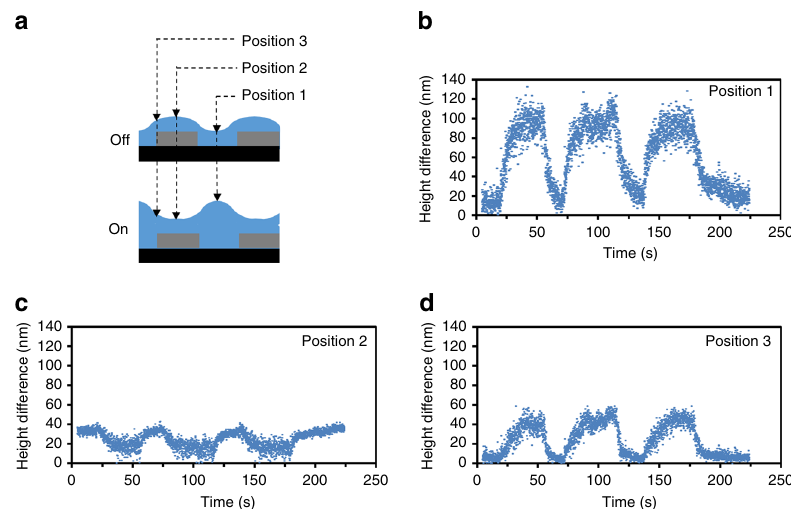
Fig. 4 Formation and relaxation kinetics of surface topographies at various positions. a Schematic cross-sections representing the LCN coating at rest ( ‘ off ’ ), and under the in fl uence of the electric fi eld ( ‘ on ’ ). b – d Dynamics of height changes in the LCN fi lm when the electric fi eld is switched ‘ on ’ and ‘ off ’ for three cycles taken from a durability test of 1200 switching times. The measurement locations for each dataset are indicated in a . The scattering of the data correspond to the chaotic oscillating dynamics. The sample is activated at 41 °C under an alternating electric fi eld of 7.5 V/ µ m at 900